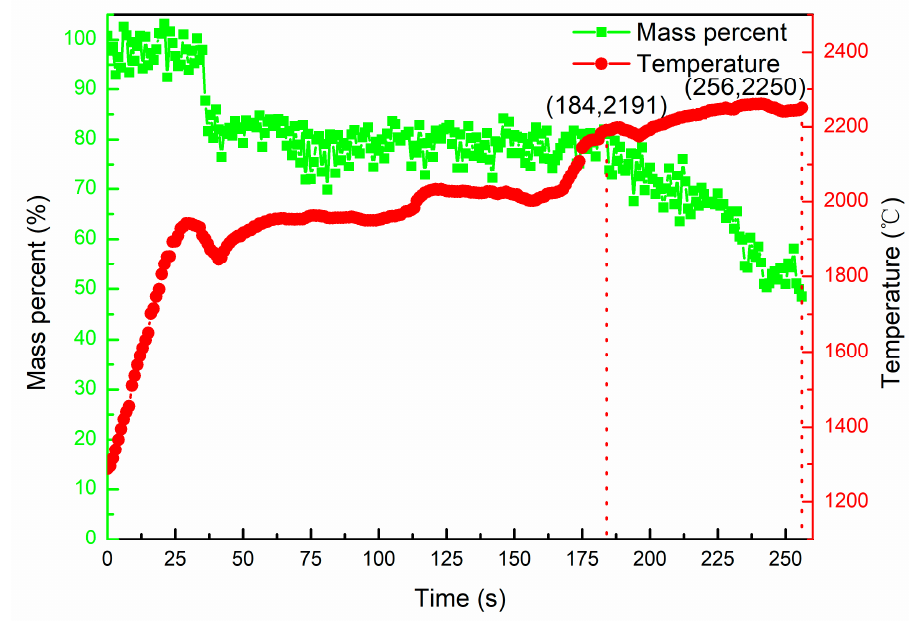
Figure 3. The vacuum evaporation of Ti by EBM.